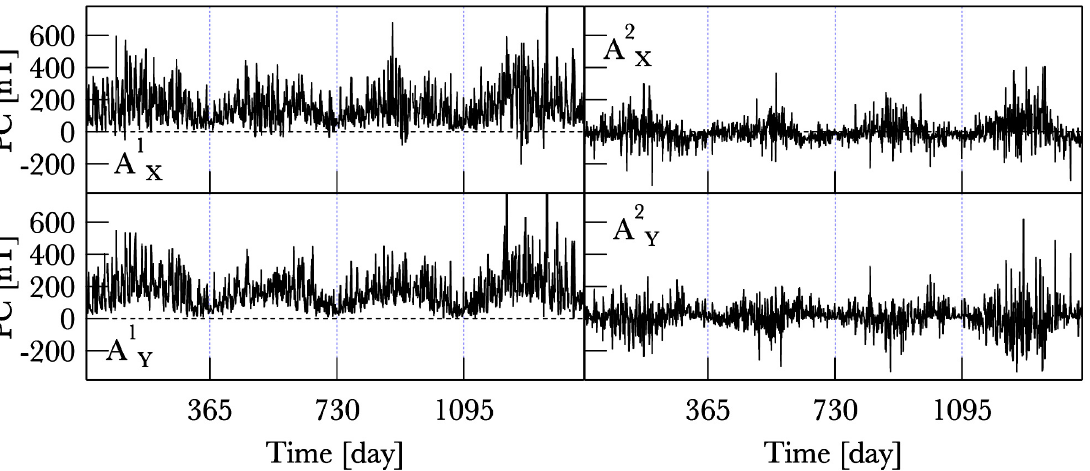
Figure 2. On the left: the PCs corresponding to the EOFs reported on the left in Figure 1. On the rigth: the PCs corresponding to the EOFs reported on the rigth in Figure